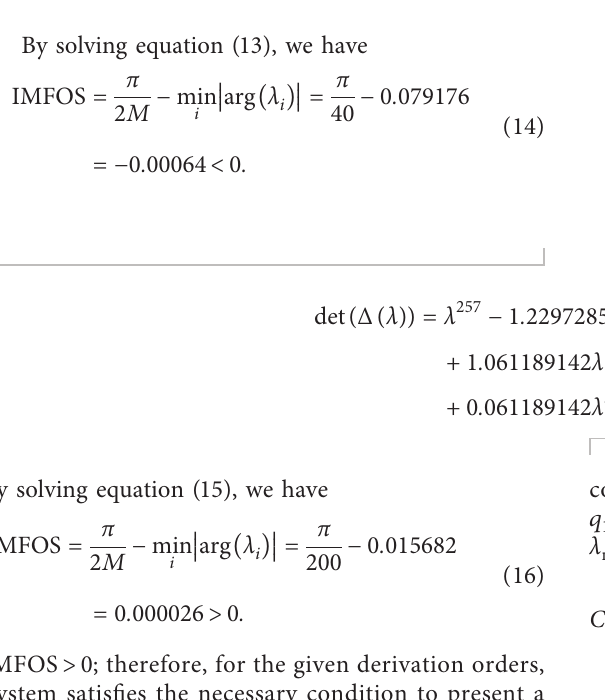
Figure 4: Largest Lyapunov exponents with variation of derivation orders: (a) q � q � when q 1 2